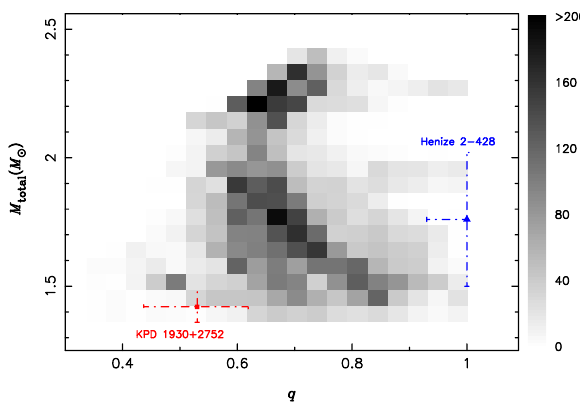
Figure 3. Density distribution of the masses of double WDs that can merge and form SNe Ia in the mass ratio−total mass ( q − M total )